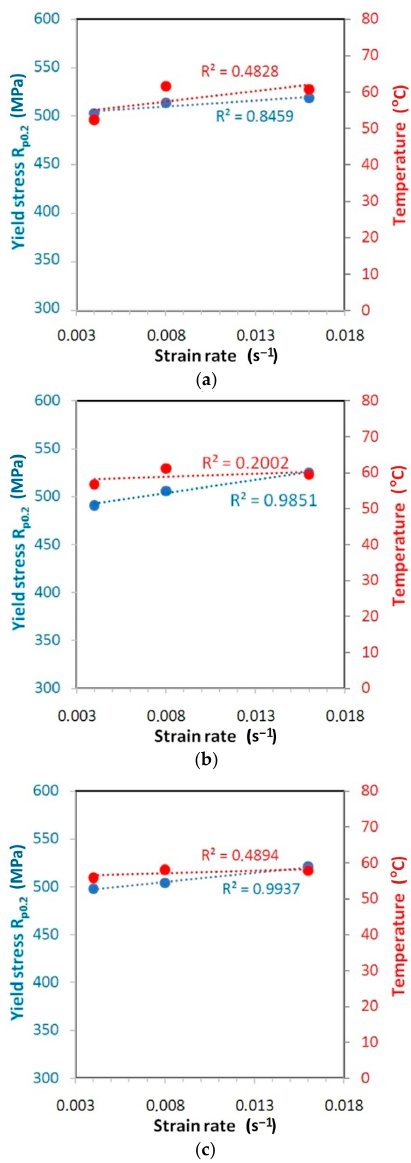
Figure 21. Correlation between the variation of the yield stress and measured temperature for the I718 specimens cut at ( a ) 0° ( ε = 33.4–34.7), ( b ) 45° ( ε = 35.1–37.3) and ( c ) 90° ( ε = 30.7–34.2). For the HX alloy, an upward trend of changes in values of both yield stress and tem- perature is visible with the increase of the strain rate. The type of correlation is quite dif- ficult to interpret. While for orientation 45° (Figure 19b) and 90° (Figure 19c) the linear correlation between yield stress and strain rate is quite strong (R 2 > 0.82), for orientation 0° (Figure 19a) the linear correlation is rather excluded (R 2 < 0.4). I625 alloy is characterised by a very small increase in yield stress value along with an increase in the strain rate from 0.004 s − 1 to 0.016 s − 1 : 0.9% (Figure 20a), 1.0% (Figure 20b) and 2.1% (Figure 20c). At the same time, there is a clear linear trend towards an increase in temperature (R 2 > 0.68). The value of yield stress for I718 alloy is linearly correlated with the increase of strain rate with coefficient of determination R 2 > 0.98 (Figure 21). However, at the same time the temper- ature variation is not linearly correlated (R 2 < 0.5) with an increase in the strain rate. The Taylor–Quinney coefficient specifies fraction of plastic work converted to heat. According to the Zehnder model [31] the coefficient β is related to the calculation of stored energy per unit of dislocation density [2]: (cid:4666)(cid:2013)̅ (cid:3043) (cid:4667) = 1 − (cid:2034)(cid:2026)(cid:3364)(cid:4666)(cid:2013)̅ (cid:3043) (cid:4667) (cid:2034)(cid:2013)̅ (cid:3043) 1 (cid:1831)(cid:3628) (cid:3084)(cid:3364)(cid:4662) (cid:3291) (3) For the work hardened Inconel alloy, the Taylor–Quinney (T-Q) coefficient under an assumption of isotropic hardening can be defined as [36]: (cid:2010)(cid:4666)(cid:2013)̅ (cid:3043) (cid:4667) = 1 − (cid:1866) (cid:3436) (cid:2013)̅ (cid:3043) (cid:2013) (cid:2868) (cid:3440) (cid:3041)(cid:2879)(cid:2869) (4) where n is the hardening exponent of the material, ε 0 is the yield strain, (cid:2013)̅ (cid:3043) is the plastic strain. Figures 22–24 show the variation of the Taylor–Quinney coefficient determined from Equation (4) with the increase of true strain. In the range of true strain from 0 to 0.05 a clear increase in the value of the T-Q coefficient is observed from a value of about 0.7. In this range of deformations, the clear influence of strain rate on the value of the T-Q coef- ficient is also visible. The rapid increase in the value of the T-Q coefficient right after reach- ing the yield stress is related to the large slope of the stress increment curve in this range (Figures 15–17). The average value of the T-Q coefficient for all test materials and strain rates was found to be equal to 0.99. There is a direct correlation of the value of the T-Q coefficient with the value of the strain hardening exponent. The lower the value of the strain hardening exponent, the greater is the value of the T-Q coefficient. The greater the true strain, the more the value of the T-Q coefficient asymptotically approaches 1 and the